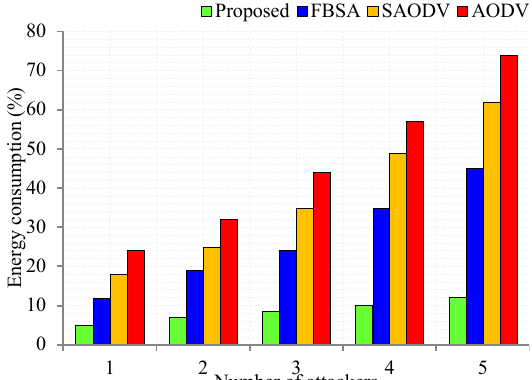
Figure 11 . Comparative analysis on energy consumption